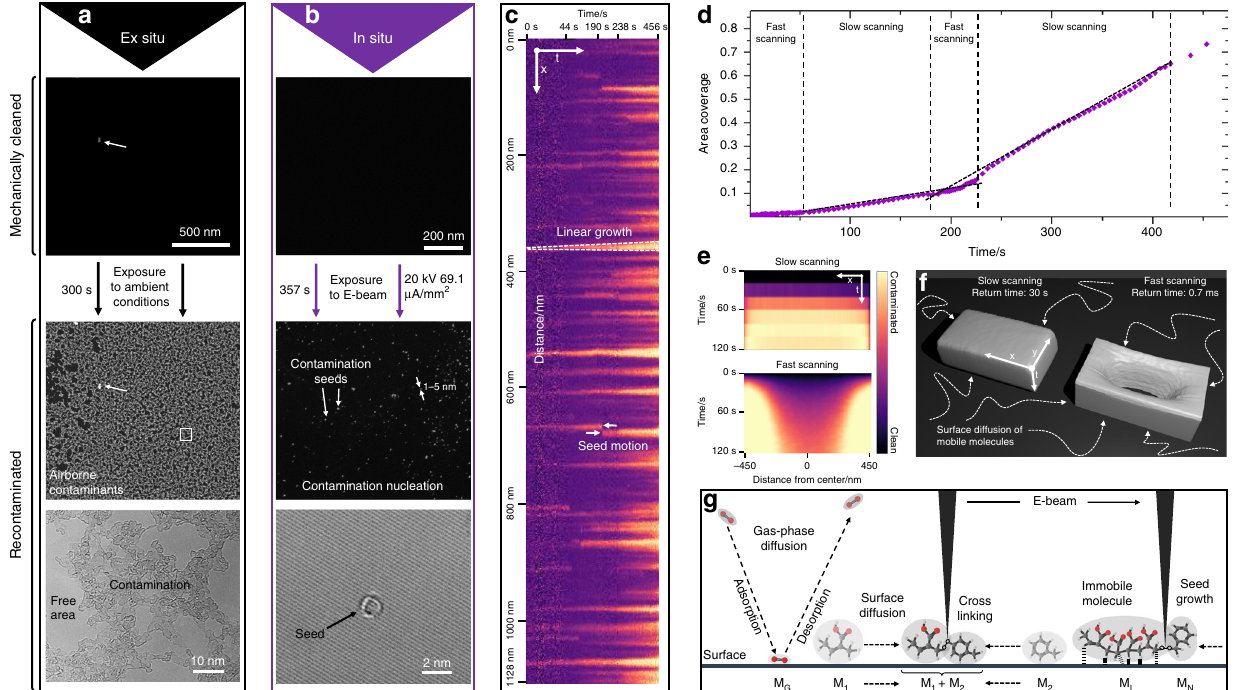
Fig. 4 Recontamination mechanisms. a Subjecting a cleaned area to ambient conditions for fi ve minutes results in a coverage with amorphous contamination. Small patches are still clean enough for HRTEM investigations. b During illumination of a cleaned area with the electron-beam contamination seeds start to form. The seeds are few nm in size and of amorphous appearance. c x-t slice of a recontamination experiment (see Supplementary Movie 3 for the whole process). Seeds grow linearly and can move by sudden jumping up to a certain size. Further seed growth increases the rate of recontamination which can also be seen in the area coverage over time ( d ). Different scan rates result in different recontamination patterns as shown in x-t slices ( e ). Scanning slowly over a cleaned area results in an even distribution of the recontamination. Conversely, fast scanning produces a stronger increase towards the edges of the pattern. f 3D representation of the x, y, t data cubes to illustrate the contamination procedure. g Schematic representation of the recontamination mechanisms. While gas-phase diffusion occurs (M G ), the cross-linking of molecules (M 1 + M 2 ) moving by surface diffusion is the main process for contamination growth. Once cross-linked molecules become immobile (M I ), they can act as a seed for further attachments (M N